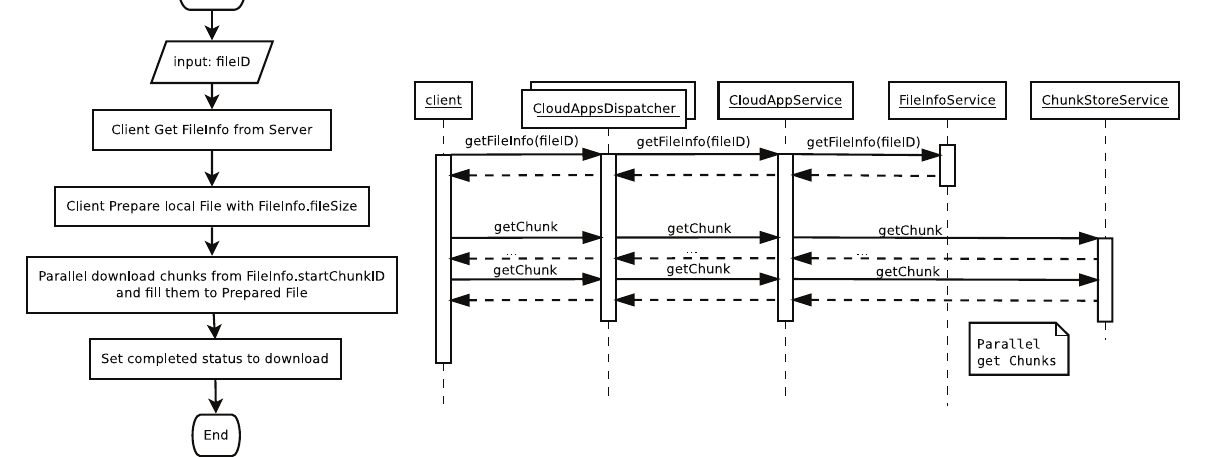
Fig. 8. Downloading Algorithm of